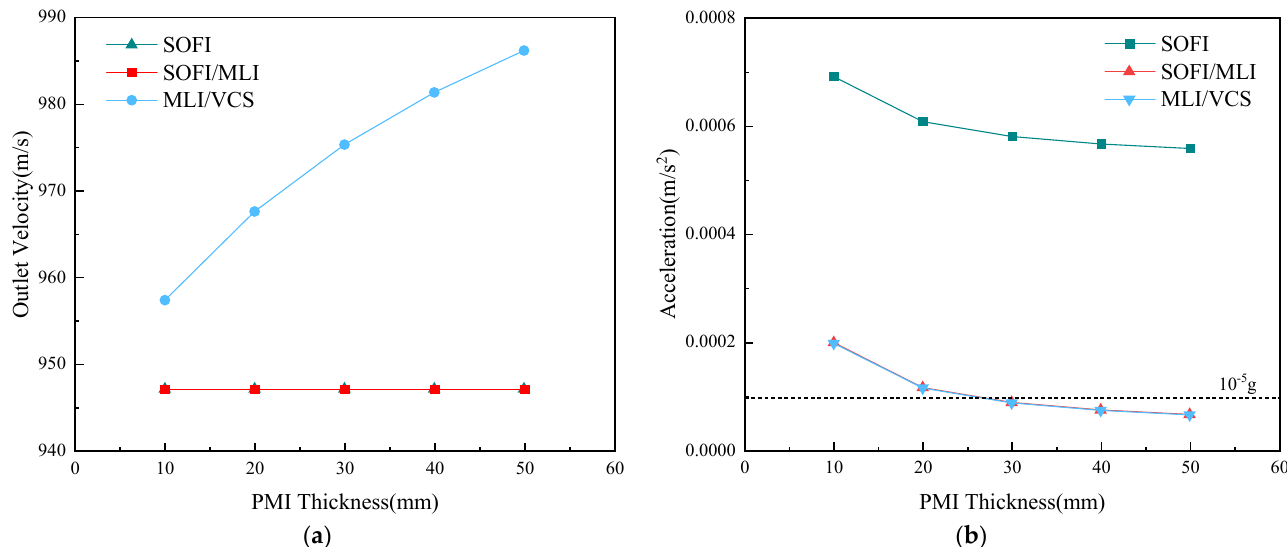
Figure 9. Parameters of the exhaust gas under di ff erent adiabatic conditions: ( a ) Laval nozzle’s outlet gas velocity; ( b ) forward exhaust